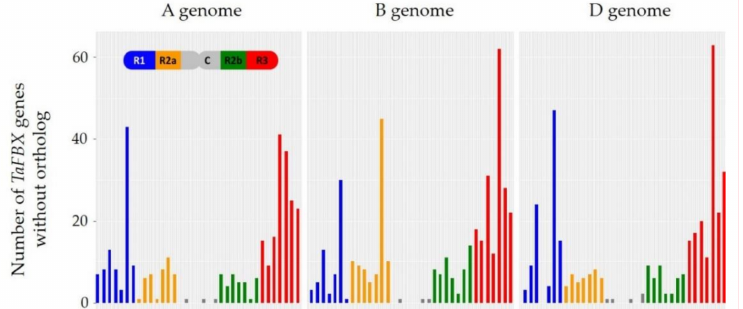
Figure 5. Chromosomal density of TaFBX genes with no orthologs identified in 18 plant species. The TaFBX density is presented along chromosomal regions (blue for R1, orange for R2a, grey for C, green for R2b and red for R3) for each chromosome of the A, B and D